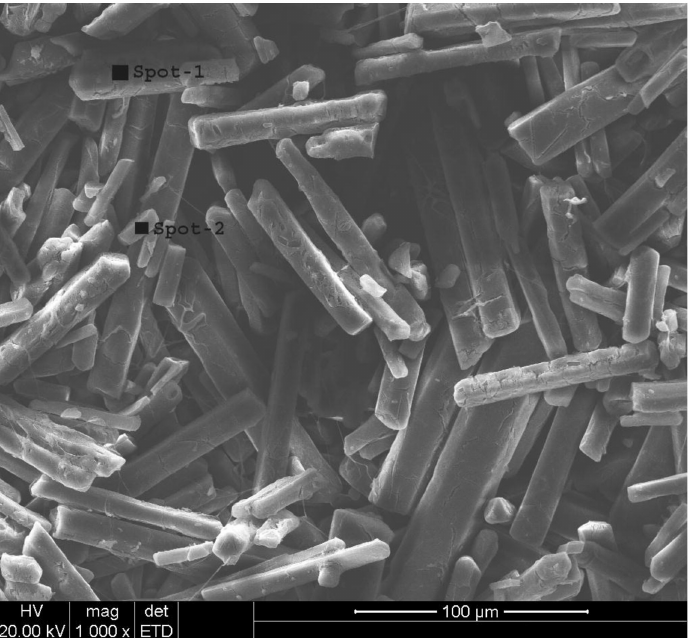
Figure 14. Scanning electron micrograph of poly(vinyl alcohol-cysteine). (Reprinted with permission from Ref. [231]. Copyright 2017 Arabian Journal of Chemistry